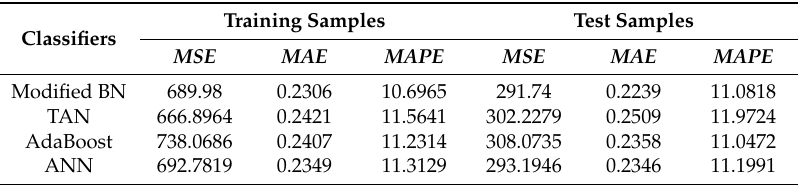
Table 10. Comparison of classifiers according to different